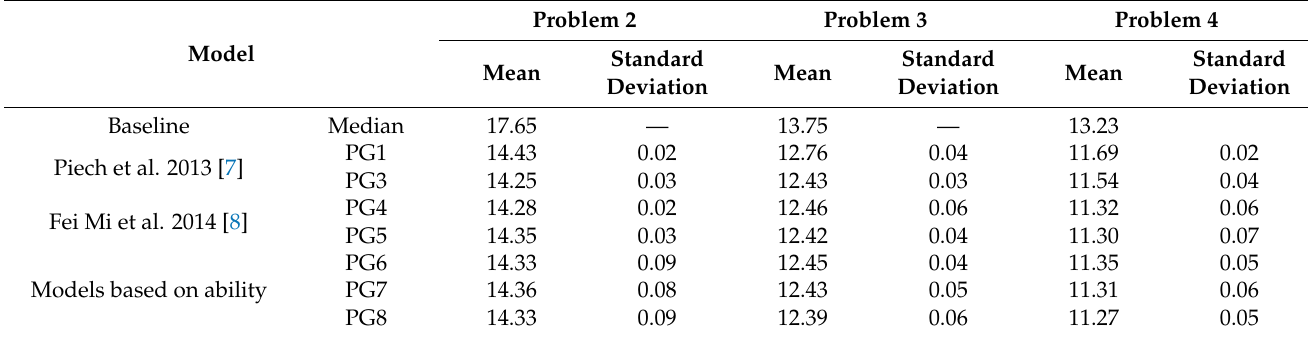
Table 2. The experimental results for the peer grades given by the graders who did not make submissions, without filtering.